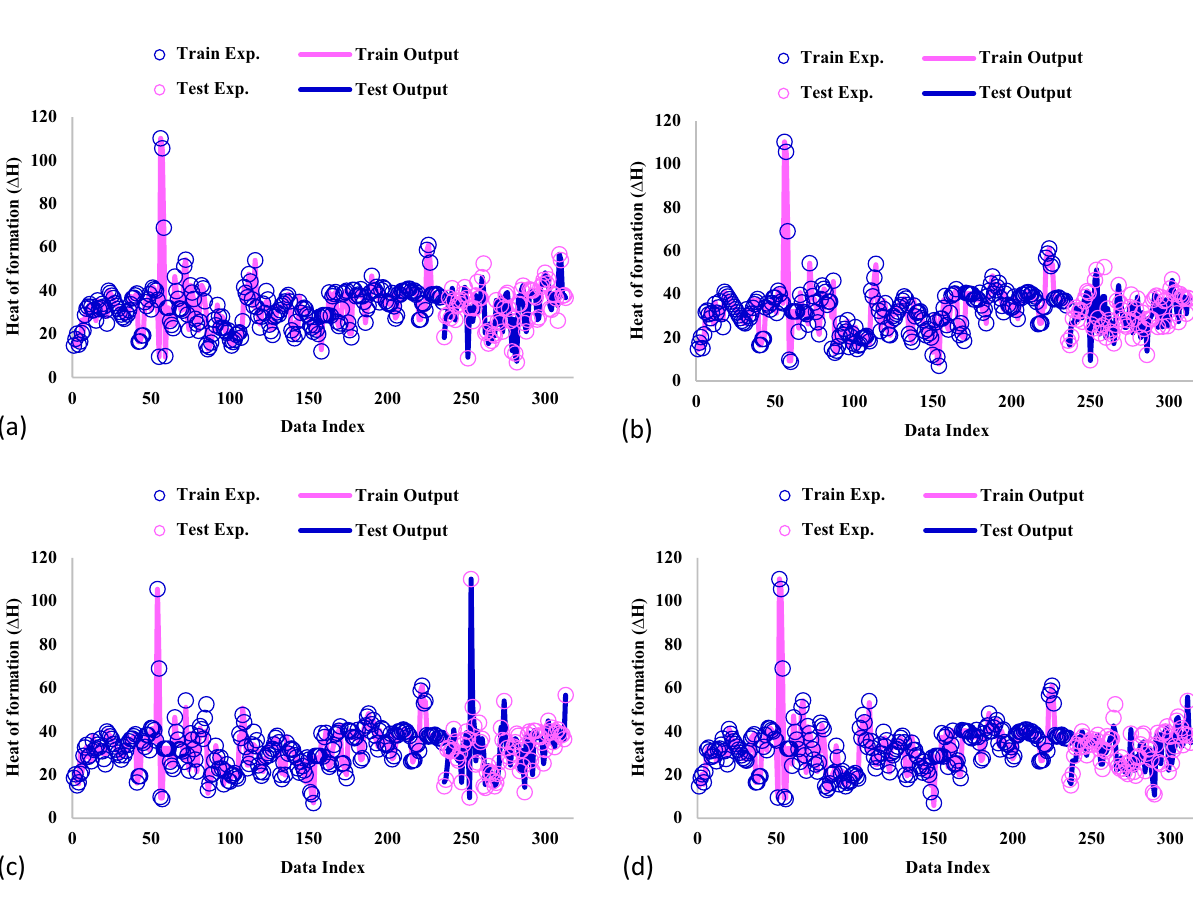
Figure 4. Comparison of actual and anticipated data for GPR model containing kernel function of ( a ) Exponential, ( b ) Matern, ( c ) Squared exponential, ( d ) Rational